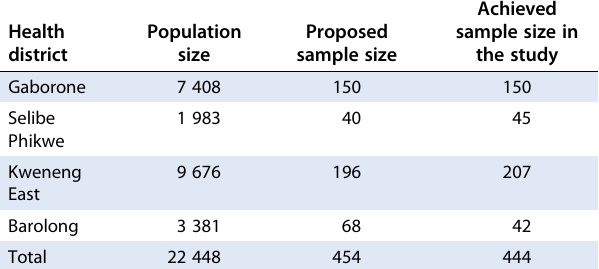
Table 1: Sample size allocation of study sample to health districts Health district